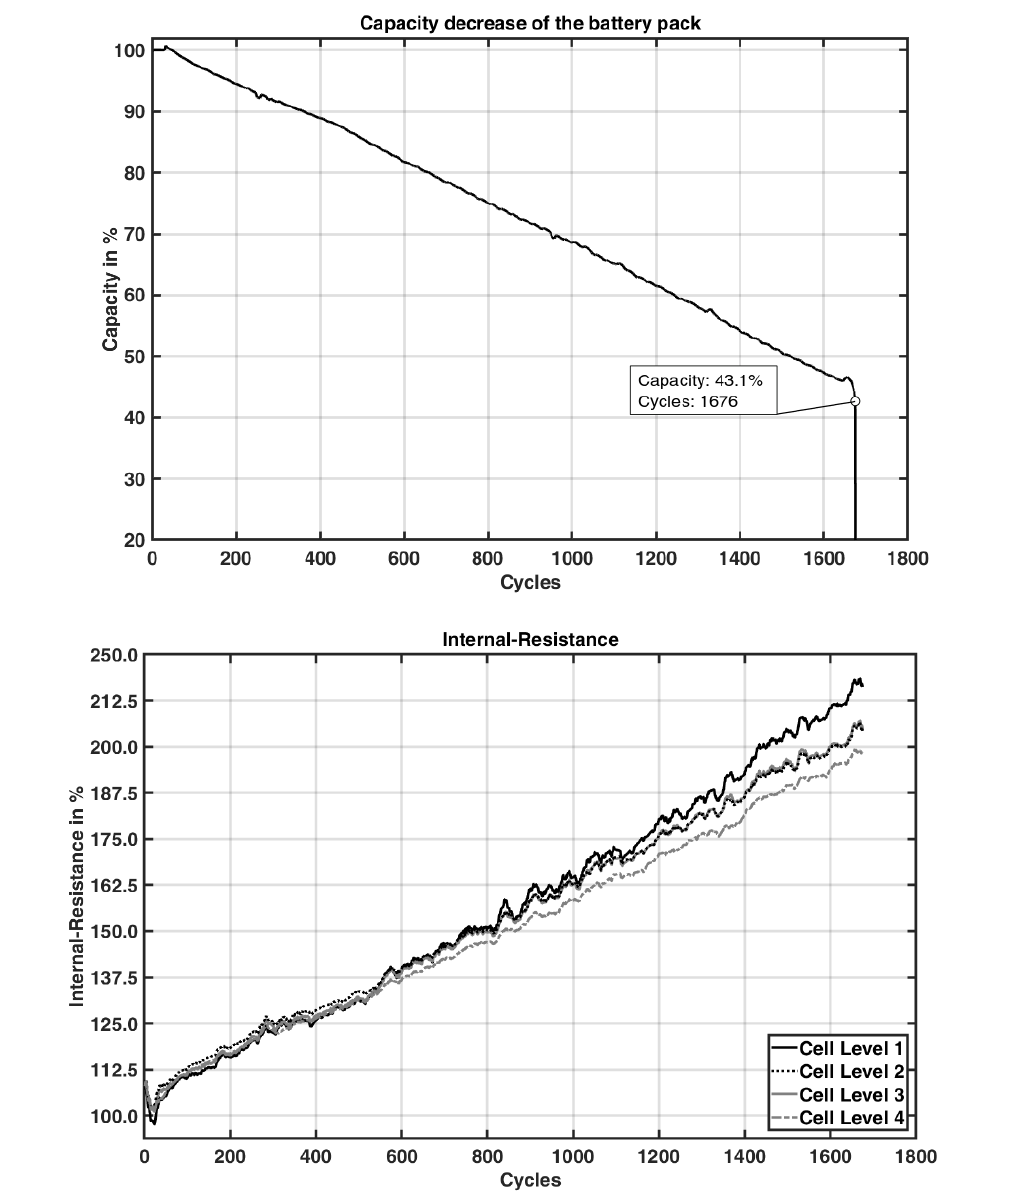
Figure 2. Capacity and internal resistance during cyclic